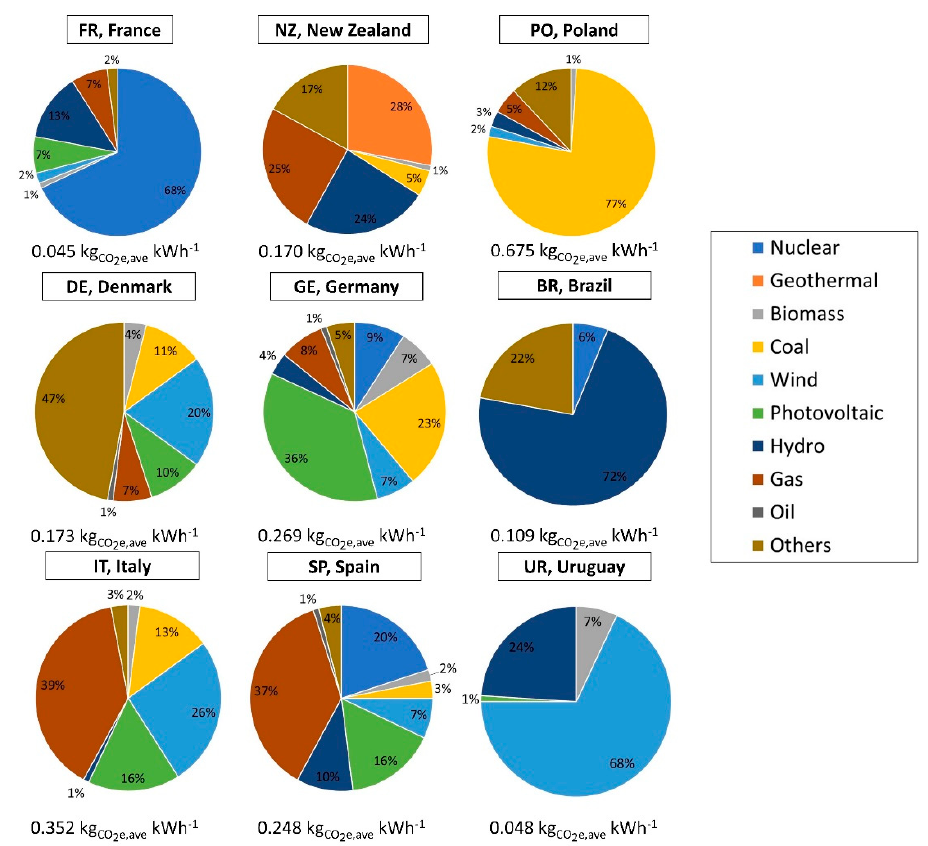
Figure 1. Fuel mix and average carbon intensity for different countries (based on data from Tomor- row [45]) .